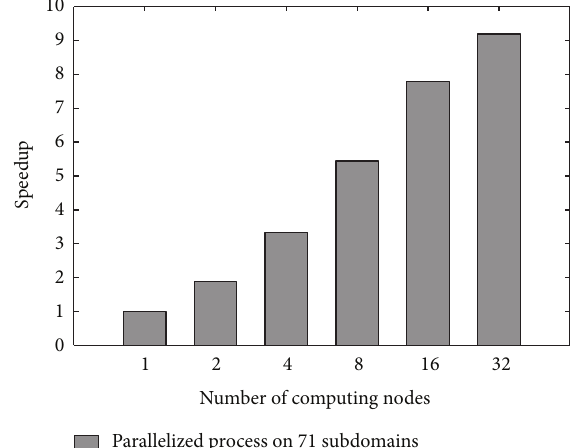
Figure 7: Speedup of parallelized process is tested on 1, 2, 4, 8, 16, and 32 computing